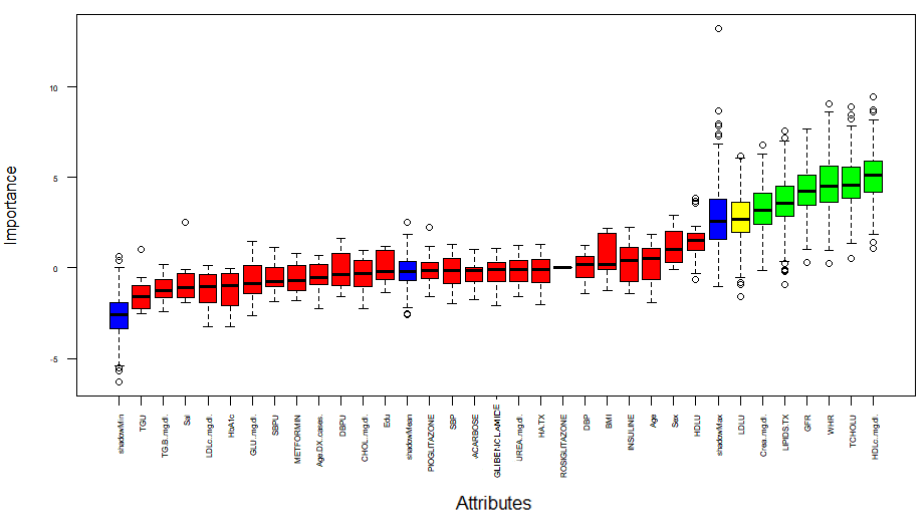
Figure 2. Feature selection process according by Boruta.